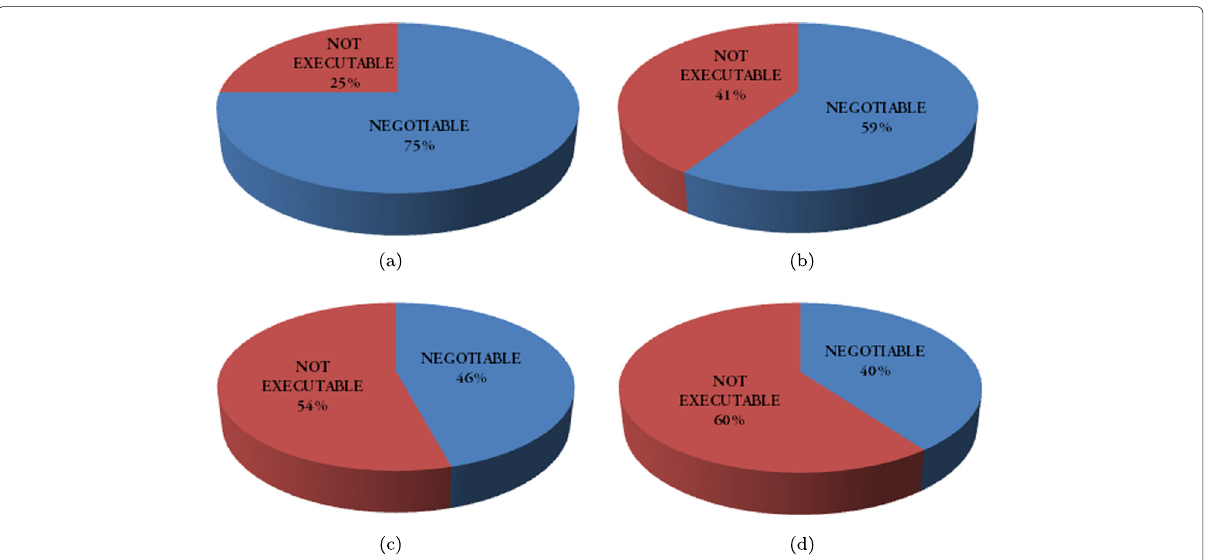
Fig. 7 Average number of services found for different restricted negotiation. a 1 QoS in priority. b 2 QoS in priority. c 3 QoS in priority. d 4 QoS in priority